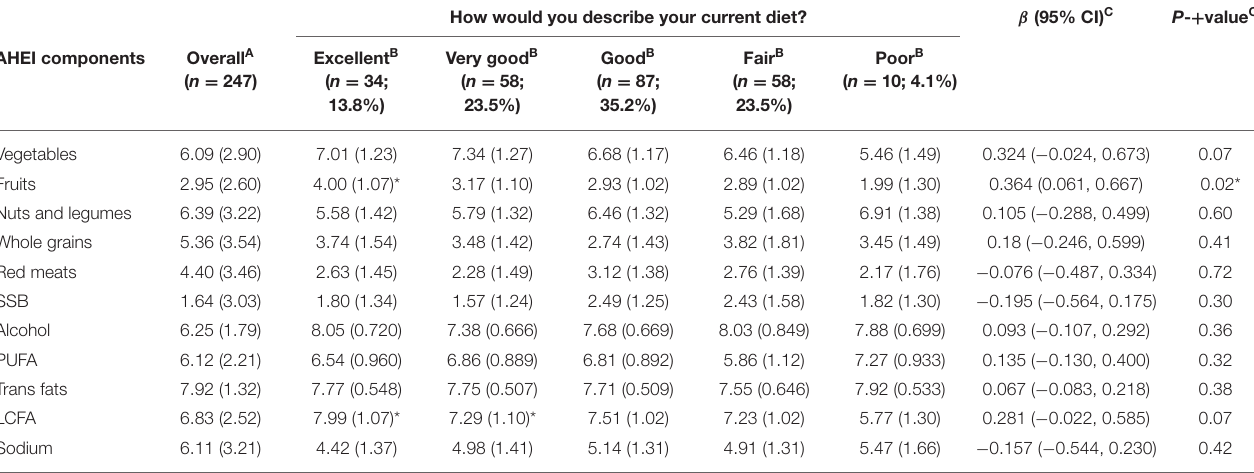
TABLE 4 | Adjusted means of Alternate Healthy Eating Index components by self-rated diet quality ( n = 247). How would you describe your current